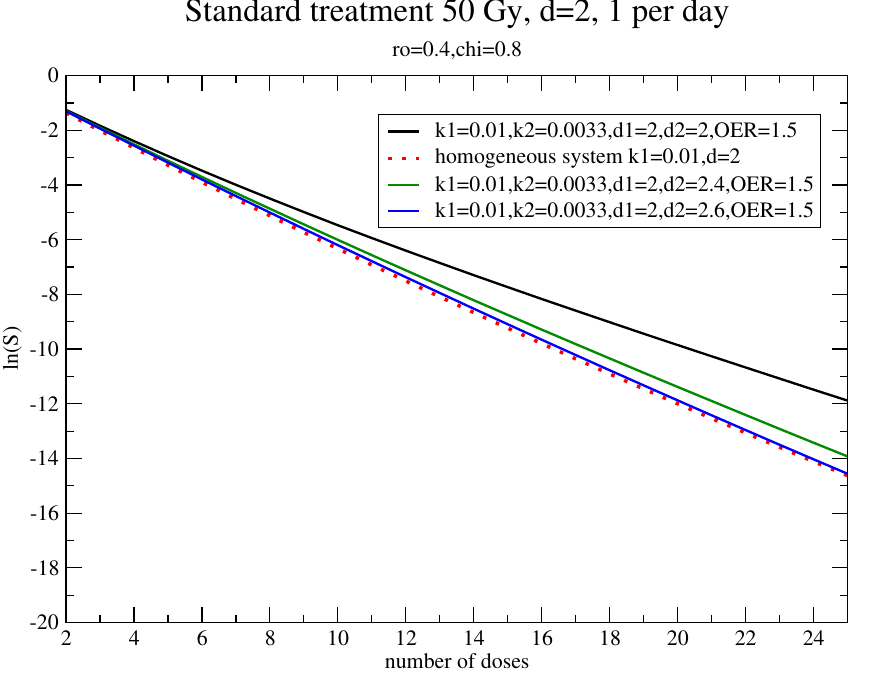
Figure 6. The survival fraction for ρ = 0.4, χ = 0.8, k g ( 2 ) = 0.0033, k g ( 1 ) = k g = 0.01, α = 0.3 Gy ( − 1 ) , β = 0.03 Gy ( − 2 ) , and OER =